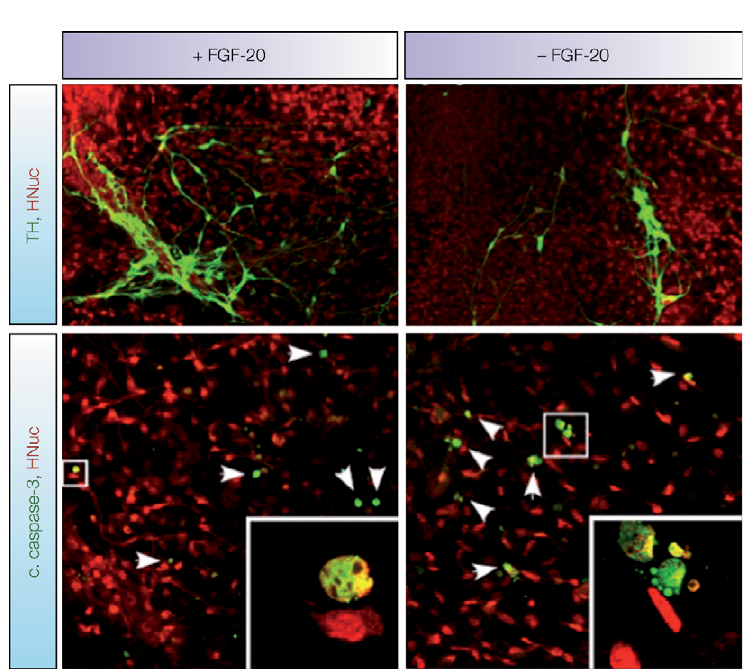
Figure 2 | Representative images of TH-, cleaved caspase-3- and HNuc-positive cells in 3 weeks differentiated hESCs/PA6 co-cultures untreated and treated with FGF-20 (–FGF-20 and + FGF-20, respectively, adapted from Correia et al., 2007